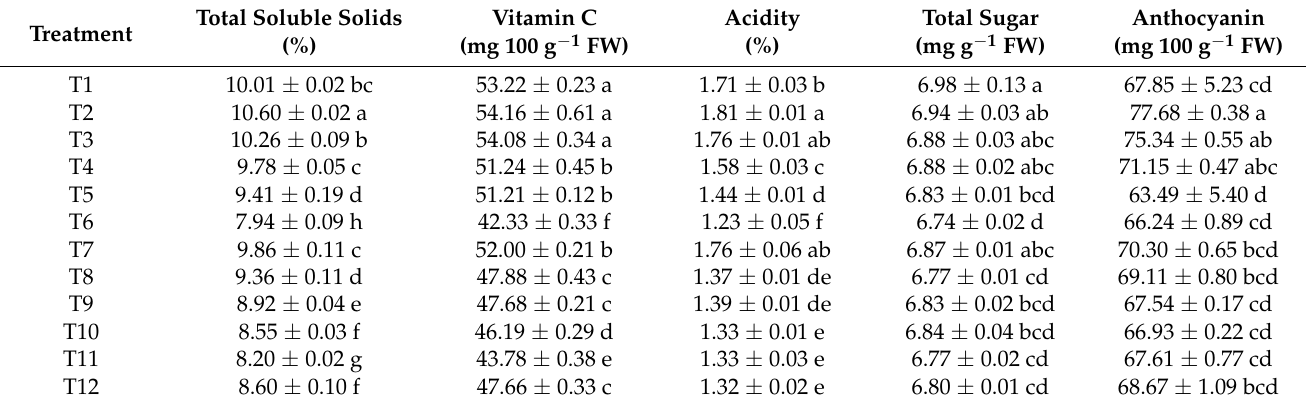
Table 6. Effect of potassium treatments on fruit quality traits of strawberry plants in the